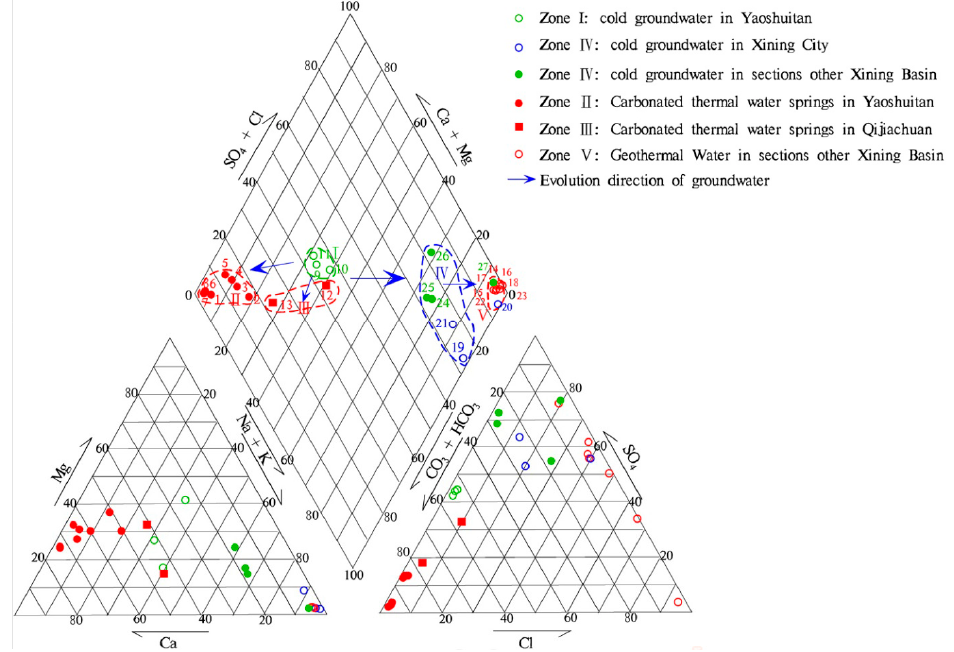
Figure 2. Piper trilinear diagram of geothermal water and cold groundwater in Xining Basin.